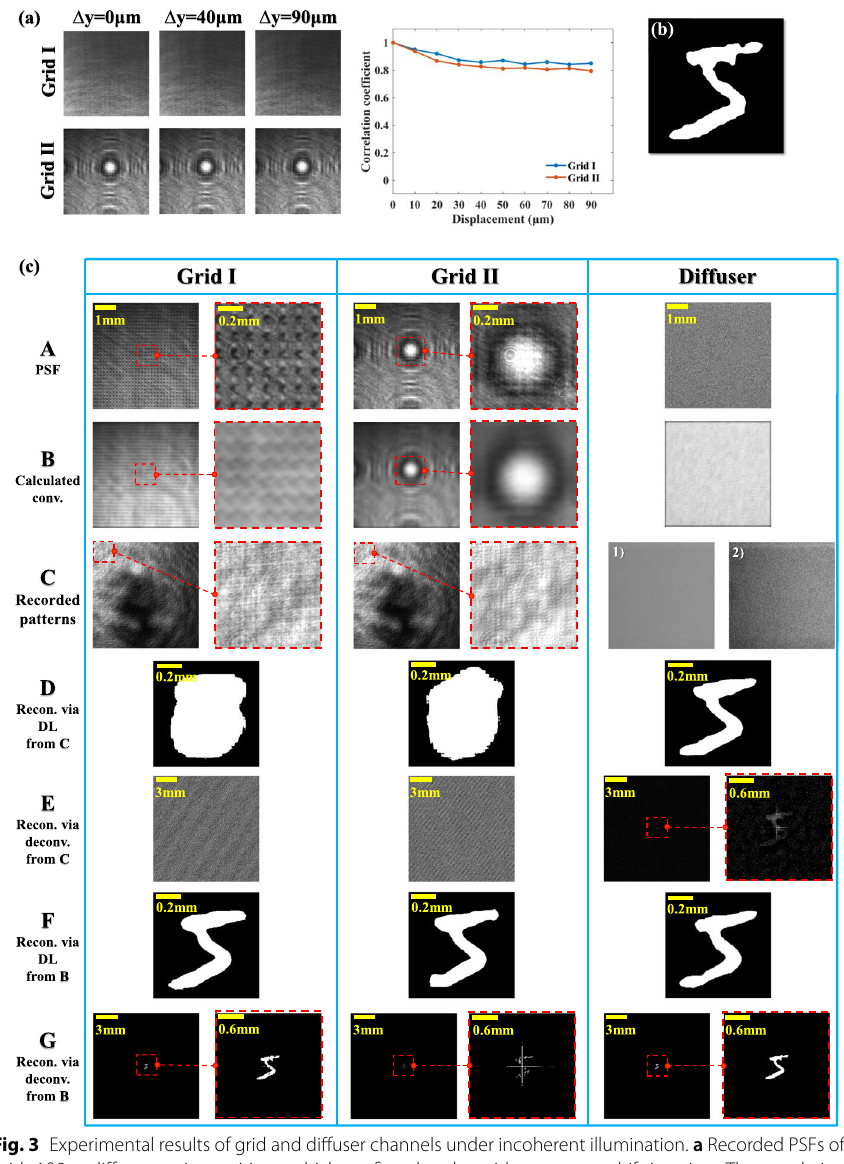
Fig. 3 Experimental results of grid and diffuser channels under incoherent illumination. a Recorded PSFs of grids 1&2 at different point positions, which confirm that the grid systems are shift-invariant. The correlation coefficient curves are flat over the scan range, which is already bigger than input objects. b Photograph of the input digit “5”. c Row A: the PSFs of different systems (Grid I, Grid II, and diffuser). From the zoom-ins we can see many fine structures. Row B: the calculated convolution of digit “5” and the corresponding PSFs. Row C: the corresponding recorded patterns by the camera. In the column for the diffuser, after contrast enhancement by the imadjust function in Matlab, fine structures, which cannot be seen in the original recorded pattern 1), become visible in 2). Rows D & E are extracted images from recorded patterns correspondingly by deep learning and deconvolution, respectively. DL is short for deep learning. Rows F & G are reconstructed images from the calculated convolution patterns by deep learning and deconvolution, respectively. The red dash square inserts show the zoom-in of original areas correspondingly. Compared to deconvolution operation, deep learning shows advantages in noise suppressing in reconstructed